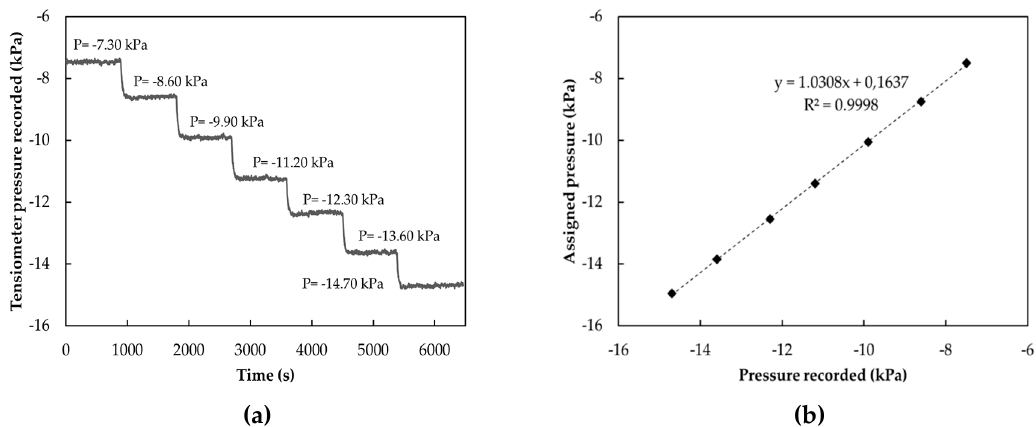
Figure 3. Example of calibration of a tensiometer: ( a ) the graph shows the recorded response, in terms of pressure values, of the instrument at the various pressures applied; and ( b ) the graph shows the calibration curve of the tensiometer used.